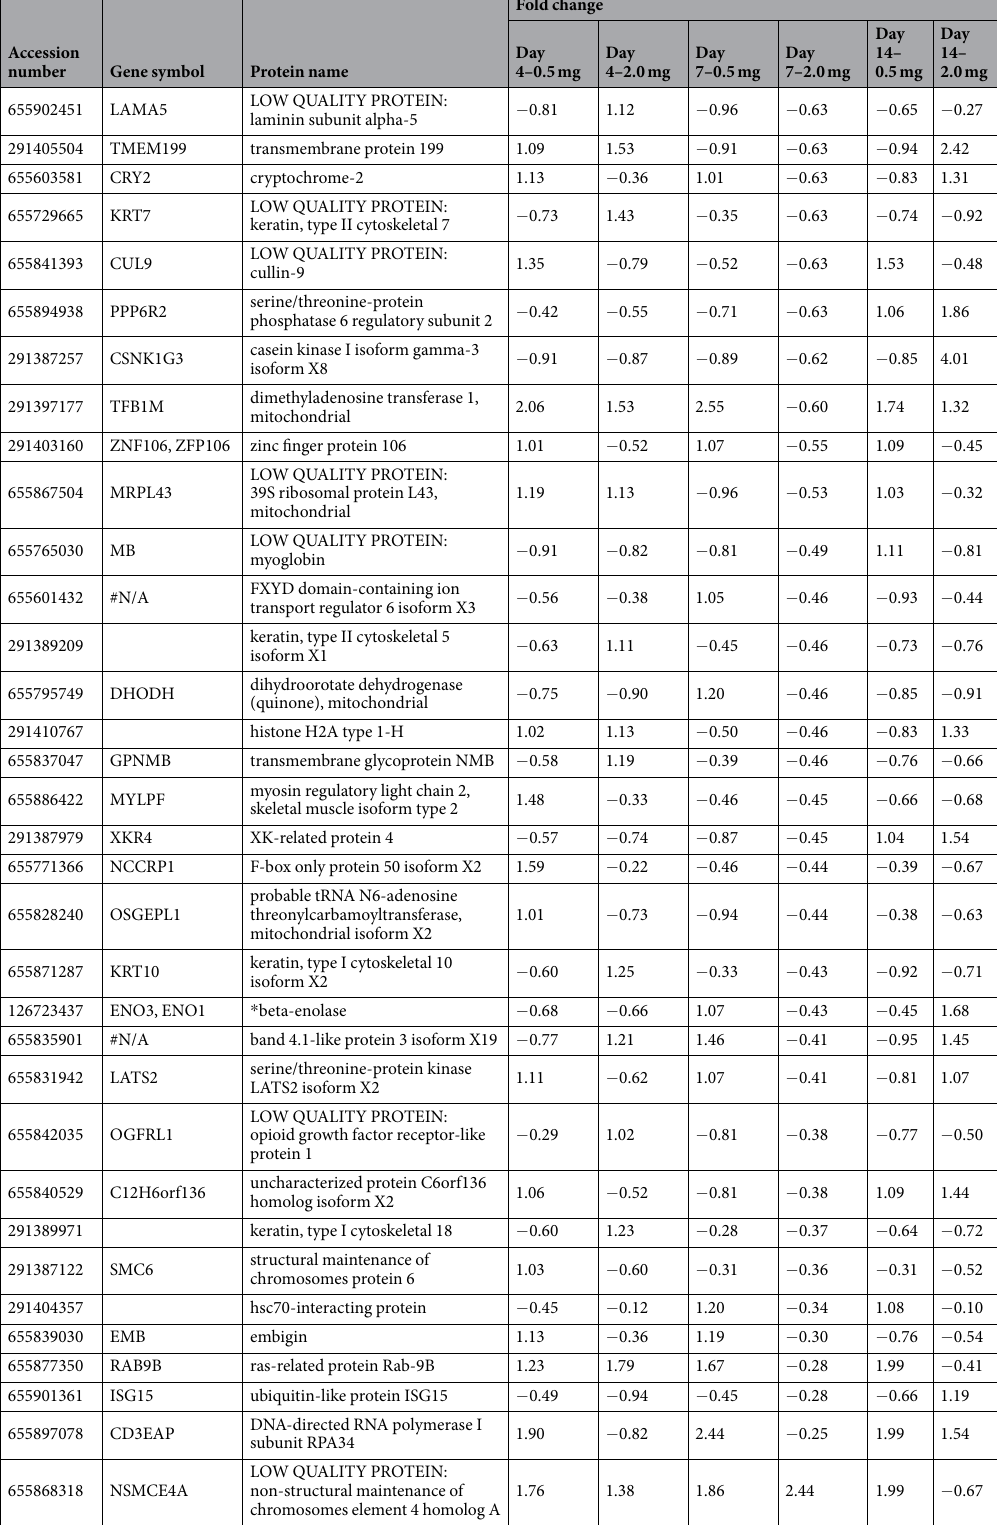
Table 3. Significantly altered proteins with inconsistent changes after intravitreal injection of conbercept. * Means the proteins are not predicted proteins. − Means